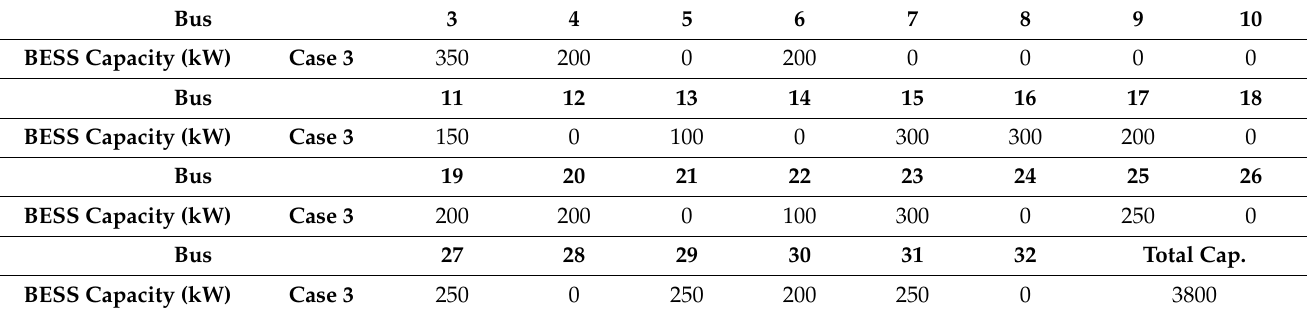
Table 2. The optimal solution for the BESS sizing and the location of Case 3.